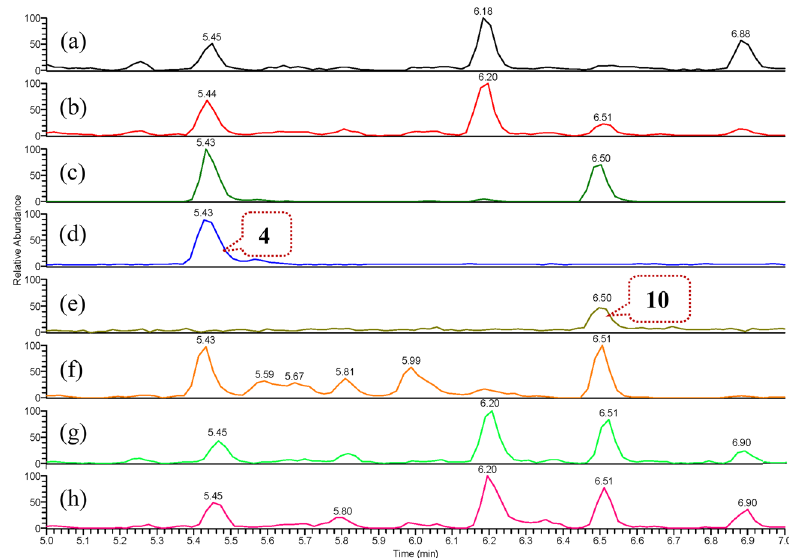
Fig. 4 Overlaid regional UPLC-HRESIMS chromatograms of extracted positive ion at m/z 415 [M + Na] + from (+)-TIC of: a aque-